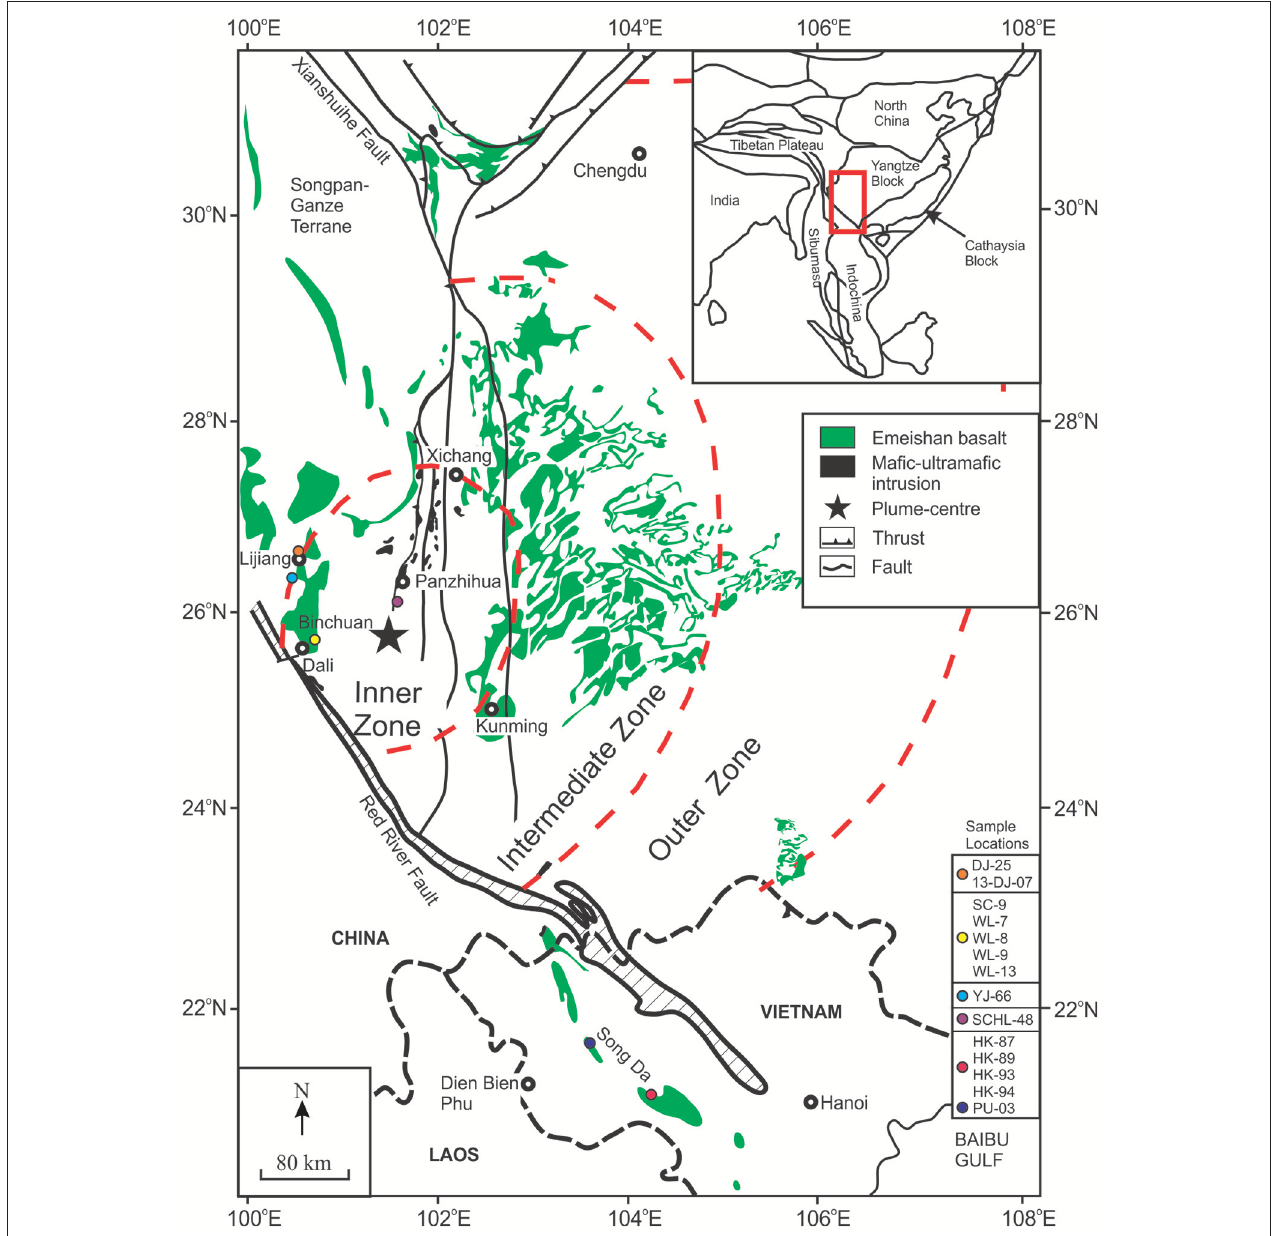
FIGURE 1 | Simplified regional geological map of the Emeishan large igneous province showing the concentric zones (dashed red lines) of the ELIP. Reproduced from Shellnutt et al. (2008) with permission. Sample locations are identified.